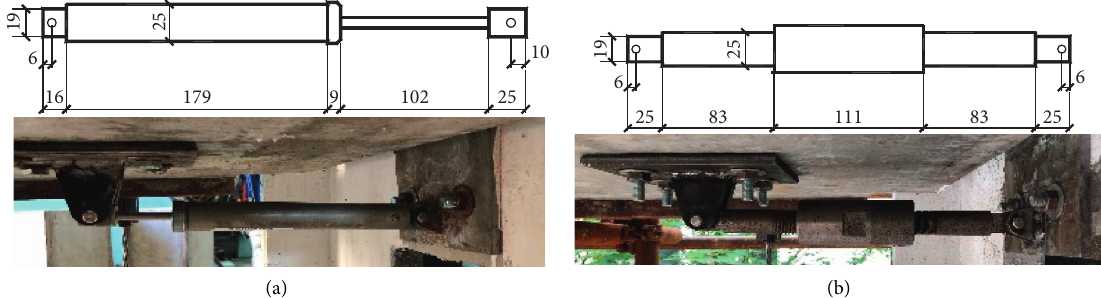
Figure 2: Schematic diagrams of two types of connections. (a) Viscous damper. (b) Rigid connecting rod. Table 1: Similarity coefficient of the test model. Physical